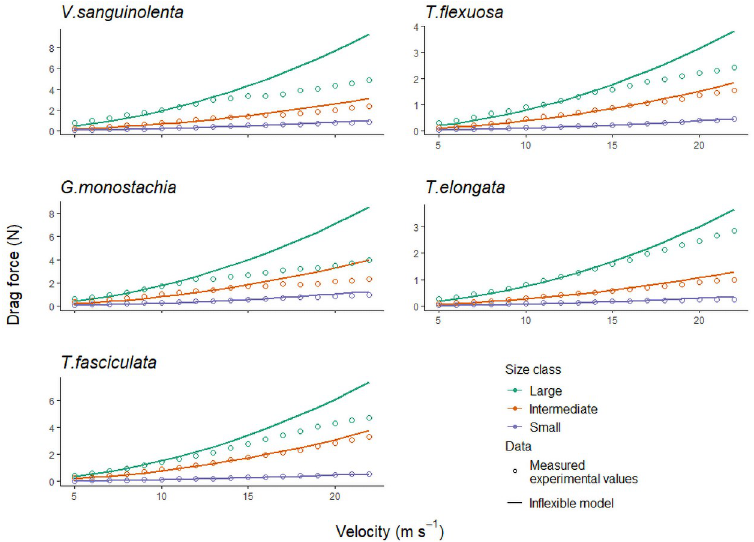
Fig 5. Reduction in drag force on different sized individuals due to reconfiguration. Drag force decreased more in larger individuals than in intermediate and small ones. Small individuals showed little to no reduction in drag forces, when compared to the inflexible models. Large individuals had longest leaf (LL) length � 35 cm; intermediate individuals had 16 cm < LL < 35 cm; small individuals had LL � 16